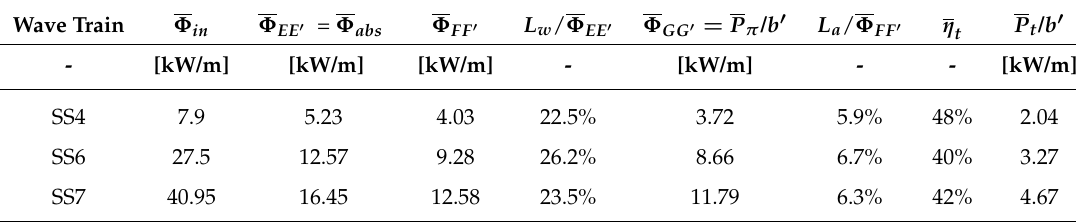
Table 7. Summary of the average power and efficiency for each simulation.